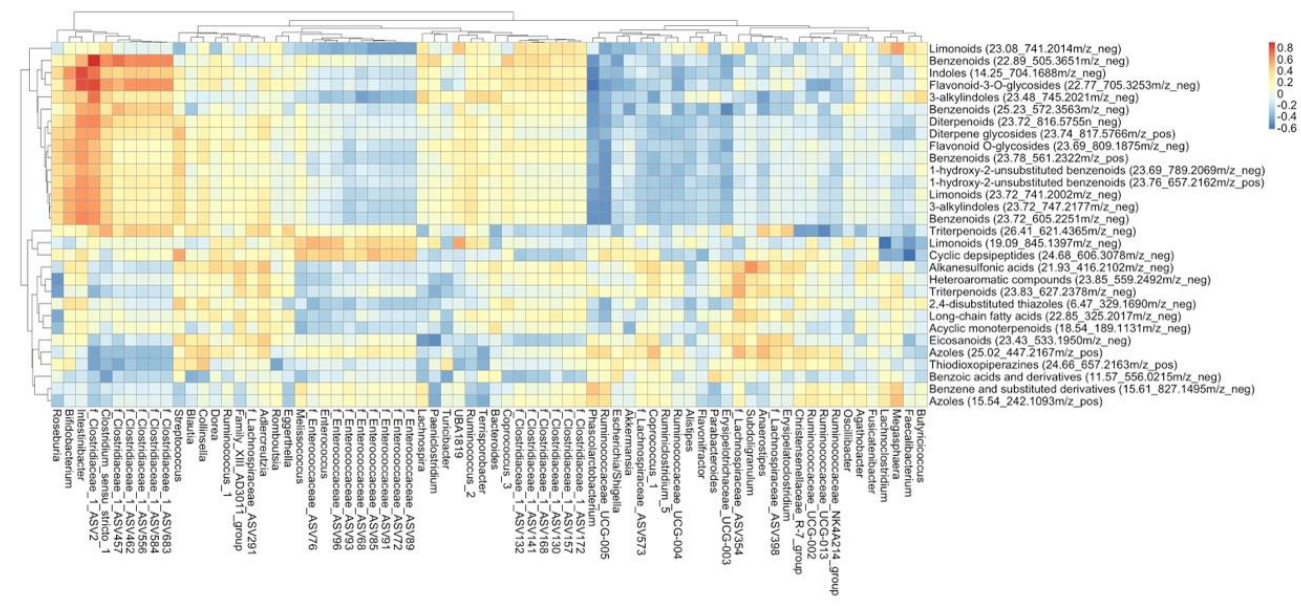
Figure 5. Correlation analysis highlights relationships between specific ASVs and metabolites. Spearman’s correlation of select metabolites with ASVs, tree represent s Euclidean clustering of me- tabolites (y-axis) and ASVs